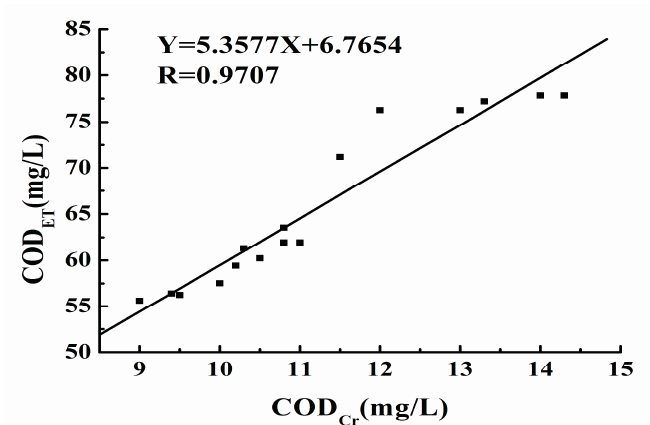
Figure 7. Correlation of COD values of real samples from rivers and lakes